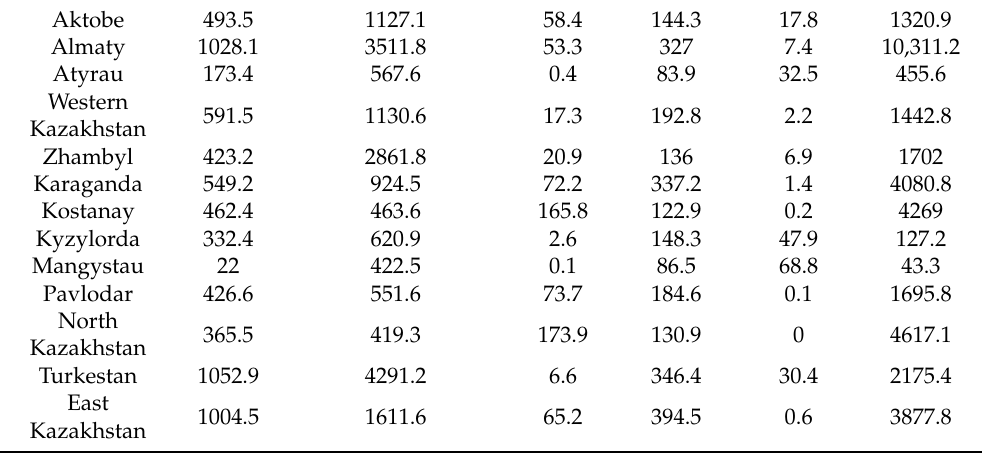
Table 4. The numbers of livestock and poultry in Kazakhstan at the end of 2019, by region [52]. Numbers of Livestock and Poultry, Thousands Regions Cattle Sheep and Goats Pigs Horses Camel Poultry